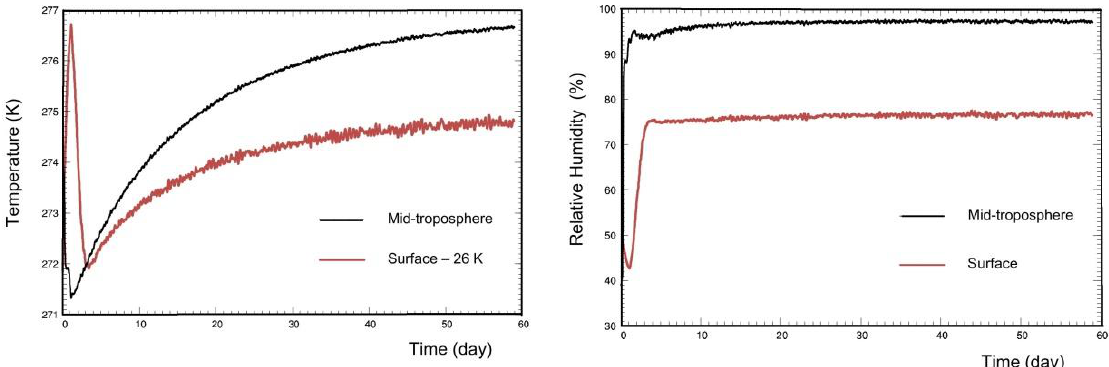
Figure 3. Time series of ( left ) the horizontally averaged air temperature and ( right ) the relative humidity near (red) the sea surface and (black) at a 4.5 km altitude. The air surface temperature is displayed with its value minus 26 K.